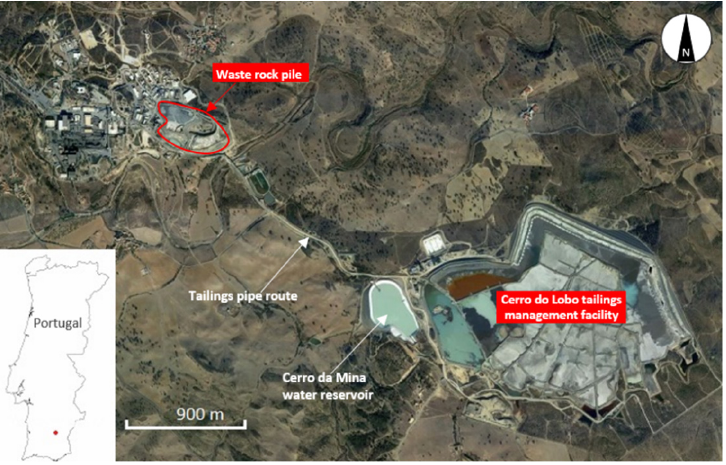
Figure 2. Map and satellite image of the Neves Corvo mine, Portugal (Coordinates: 37°33 ′ 53 ′′ N 7°57 ′ 13 ′′ W). The original satellite image was obtained from Google Earth.